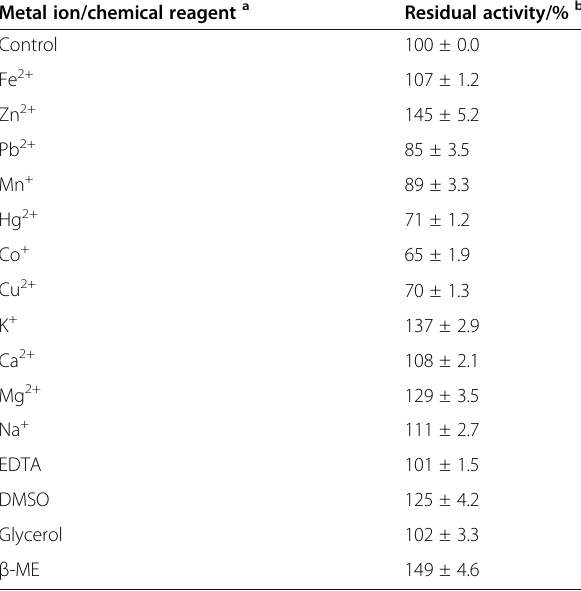
Table 5 Relative rate of hydrolysis of various substrates by Aspergillus sp. DHE7 β -glucosidase Substrate